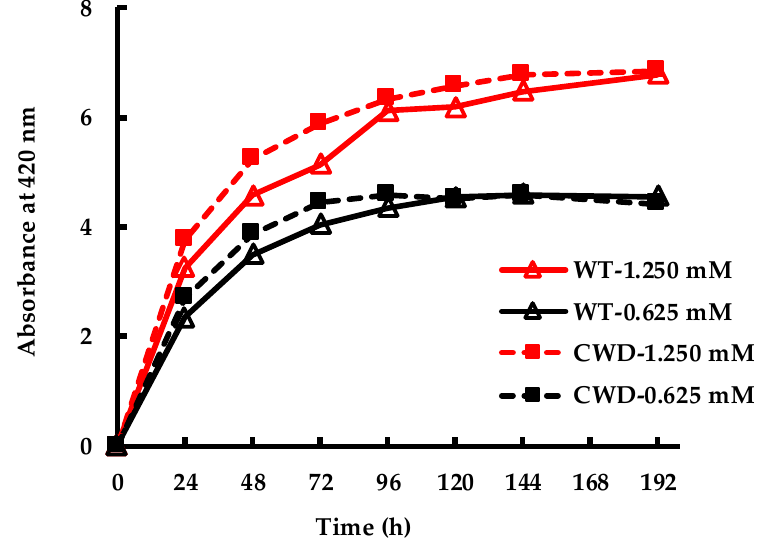
Figure 3. Evolution of AgNP SPR peak vs. time for WT and CWD strains at 1.250 mM and 0.625 mM AgNO 3 concentrations.